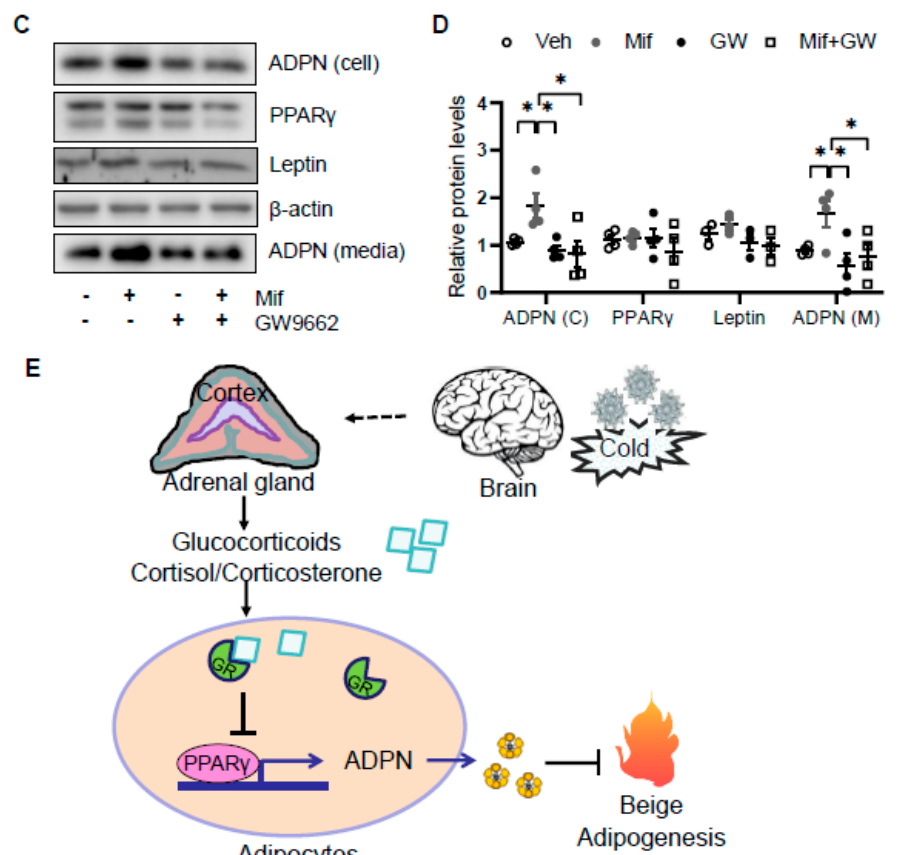
Figure 5. Glucocorticoid receptor signaling suppresses adiponectin expression by inactivating PPAR γ . ( A ) The suppressing effects of GCs on adiponectin expression was attenuated by PPAR γ agonist rosiglitazone in differentiated 3T3-L1 adipocytes. Cells were treated with 2 μ M rosiglitazone for 1 h followed by the co-treatment of 2 μ M hydrocortisone for 24 h. ( B ) The statistical analysis of the results in Figure 5A. White dots, vehicle group ( n = 3); gray dots, hydrocortisone group ( n = 3); black dots, rosiglitazone group ( n = 3); and white square, hydrocortisone and rosiglitazone cotreatment group ( n = 3). ( C ) The inducing effects of mifepristone on adiponectin were suppressed by the treatment of PPAR γ antagonist GW9662 in differentiated 3T3-L1 adipocytes. Cells were treated with 20 µ M PPAR γ antagonist GW9662 for 1 h followed with the co-treatment of 2 µ M mifepristone for 24 h. ( D ) The statistical analysis of the results in Figure 5C. White dots, vehicle group ( n = 4); gray dots, mifepristone group ( n = 4); black dots, GW9662 group ( n = 4); and white square, mifepristone and GW9662 cotreatment group ( n = 4). Hydro, hydrocortisone; Ros, rosiglitazone; Mif, Mifepristone; and GW, GW9662. ( E ) A schematic model showing that cold stress-elevated GCs promote thermogenesis by suppressing adiponectin production. The data in Figure 5B,D are presented as the mean ± S.E.M. * p < 0.05, ** p <